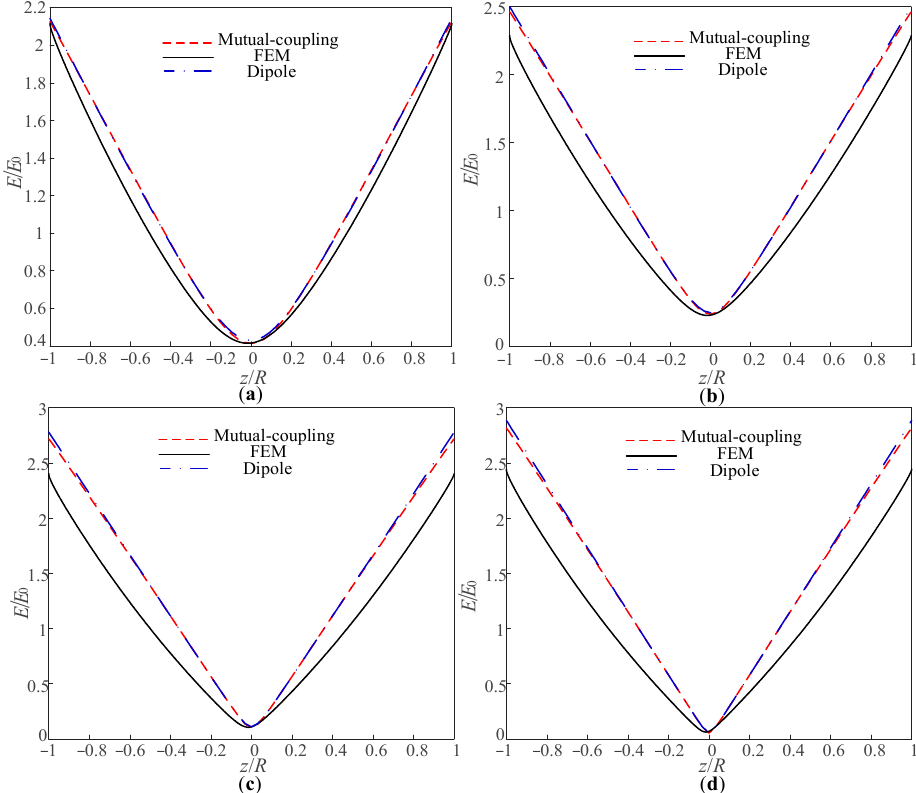
Figure 12. Calculation results of the electric field distribution on particle 1 when D / R = 1.5: ( a ) Calculation results when ε i / ε e = 5; ( b ) Calculation results when ε i / ε e = 10; ( c ) Calculation results when ε i / ε e = 25; ( d ) Calculation results when ε i / ε e = 50.